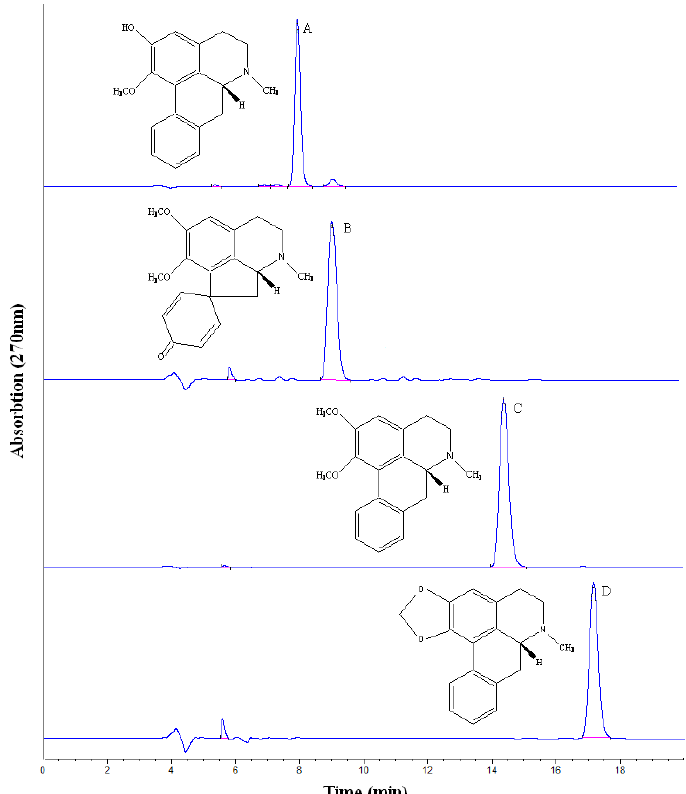
Figure 3. HPLC analyses of the fractions obtained by HSCCC. HPLC analysis conditions are the same as shown in Figure 2. A: 2-hydroxy-1-methoxyaporphine; B: pronuciferine; C: nuciferine; D: